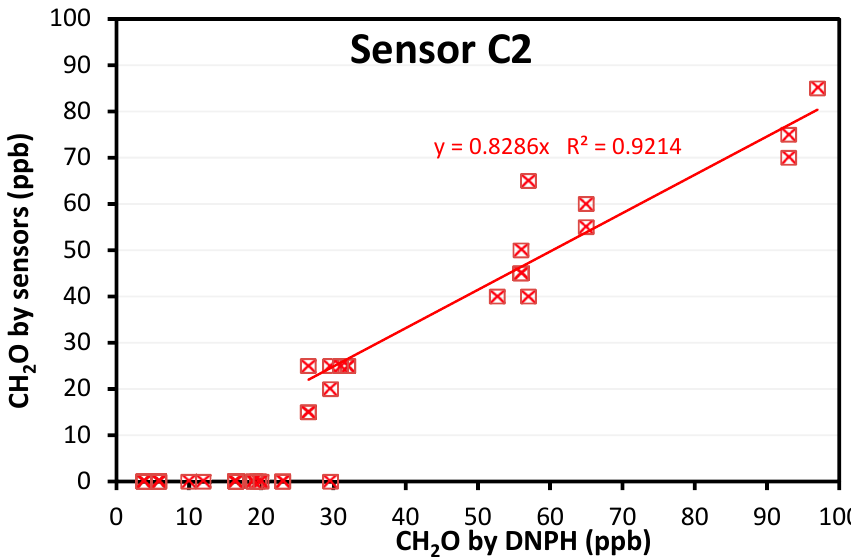
Figure 6. Corrected HCHO concentration (ppb) for Sensor C1 and regression line versus reference method (DNPH).